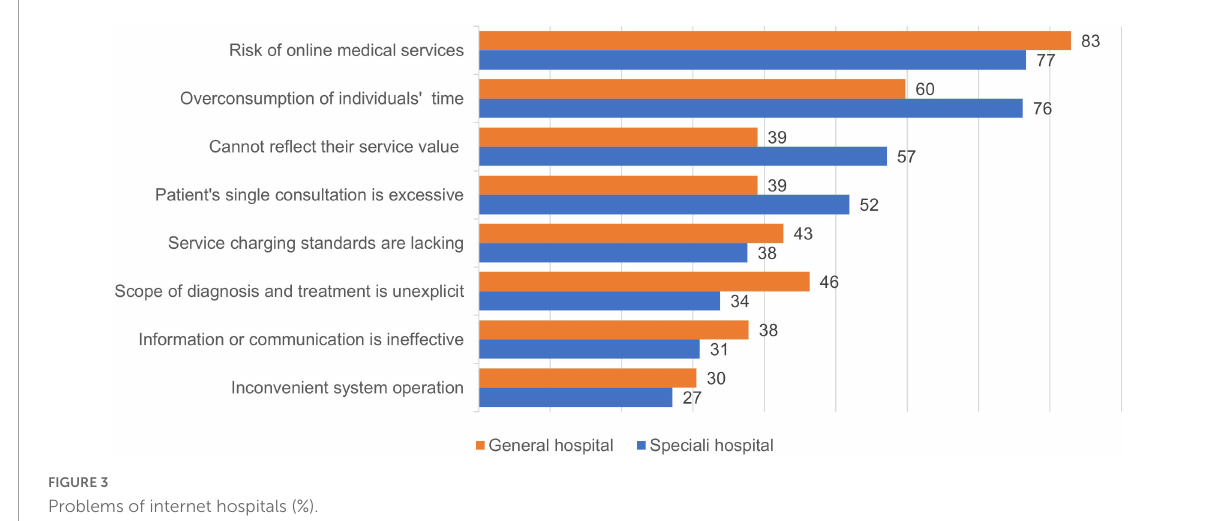
FIGURE3 Problems of internet hospitals